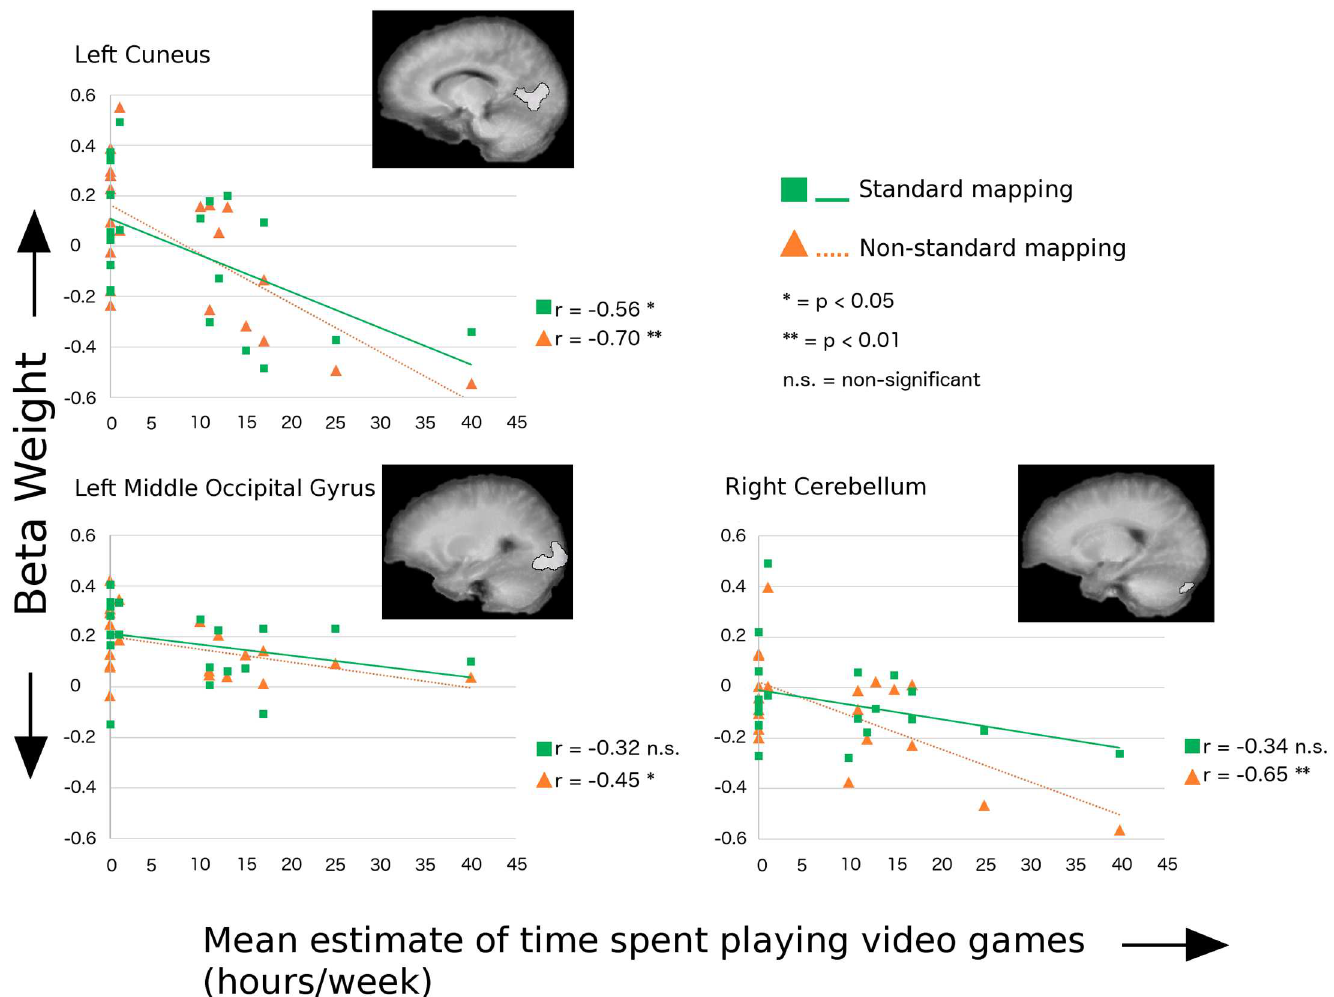
Fig 3. Relationship between preparatory BOLD signal and time spent playing. Linear regression results for mean instructed-delay epoch BOLD signal beta weights versus estimates of time spent playing action video games in regions of interest with significantly lower amplitude BOLD signal in the AVG player group compared with the non-player group. Regions of interest are displayed on each regression plot as overlays on the mean T1-weighted anatomical images for all participants. The Standard visuomotor mapping is represented by green squares and solid green lines. The Non-Standard visuomotor mapping is represented by orange triangles and dashed orange lines. See Table 2 for specific p -values.